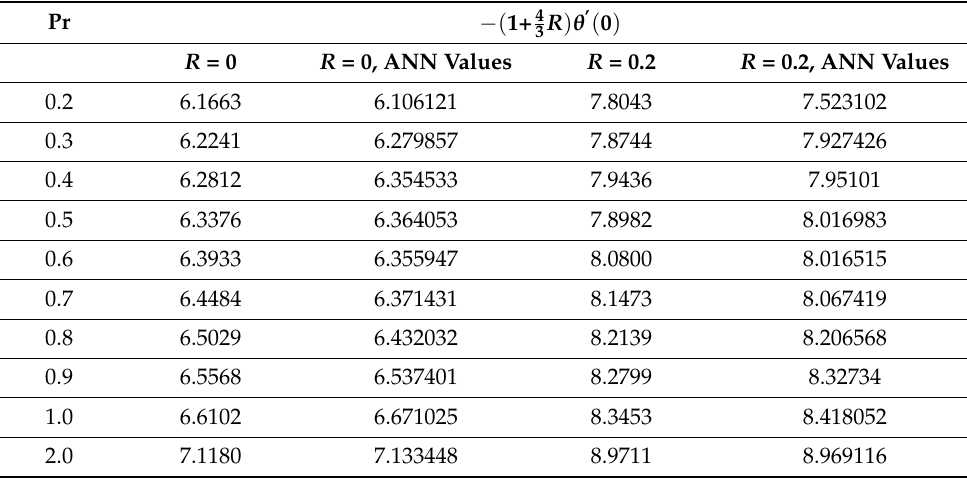
Table 9. Impact of Prandtl number on Nusselt number for non-radiative and radiative flow